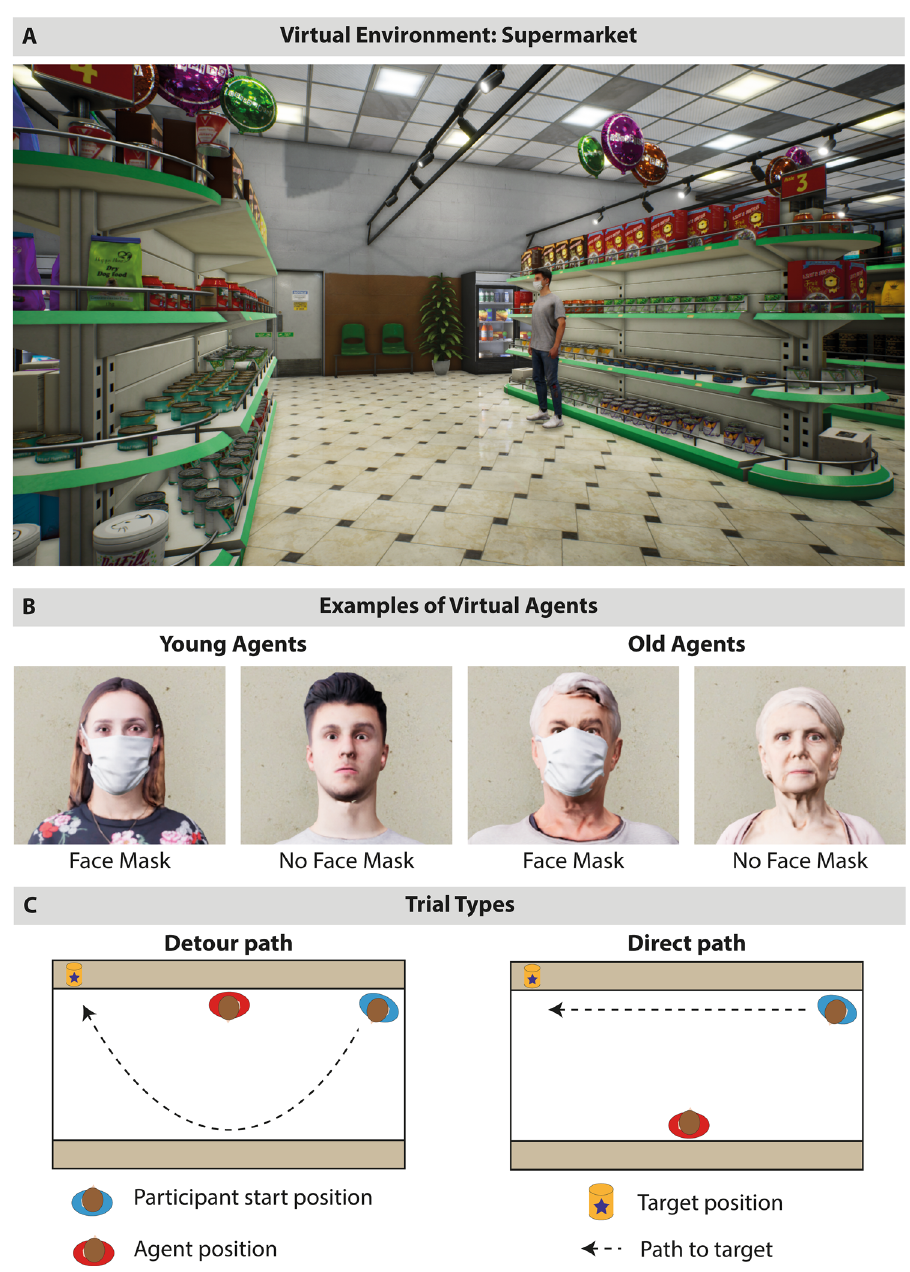
Figure 1. Virtual environment, virtual agents, and trial types. ( A ) Illustration of the virtual supermarket aisle in which the experiment took place. Here a young agent is depicted in the Other Face Mask On condition. ( B ) Example stimuli of young and old virtual agents with and without face masks. Note that every agent was presented both with and without face mask across trials. ( C ) Schematic illustration on the supermarket aisle from a bird’s eye view. Left side shows a detour path trial where the participant (blue) has to take a detour (dashed line) around the agent (red) in order to reach the target (yellow can) while maintaining a minimal distance of 1.5 m. Right side shows a direct path trial where the target can be reached directly and without taking a detour while maintaining a minimum distance of 1.5